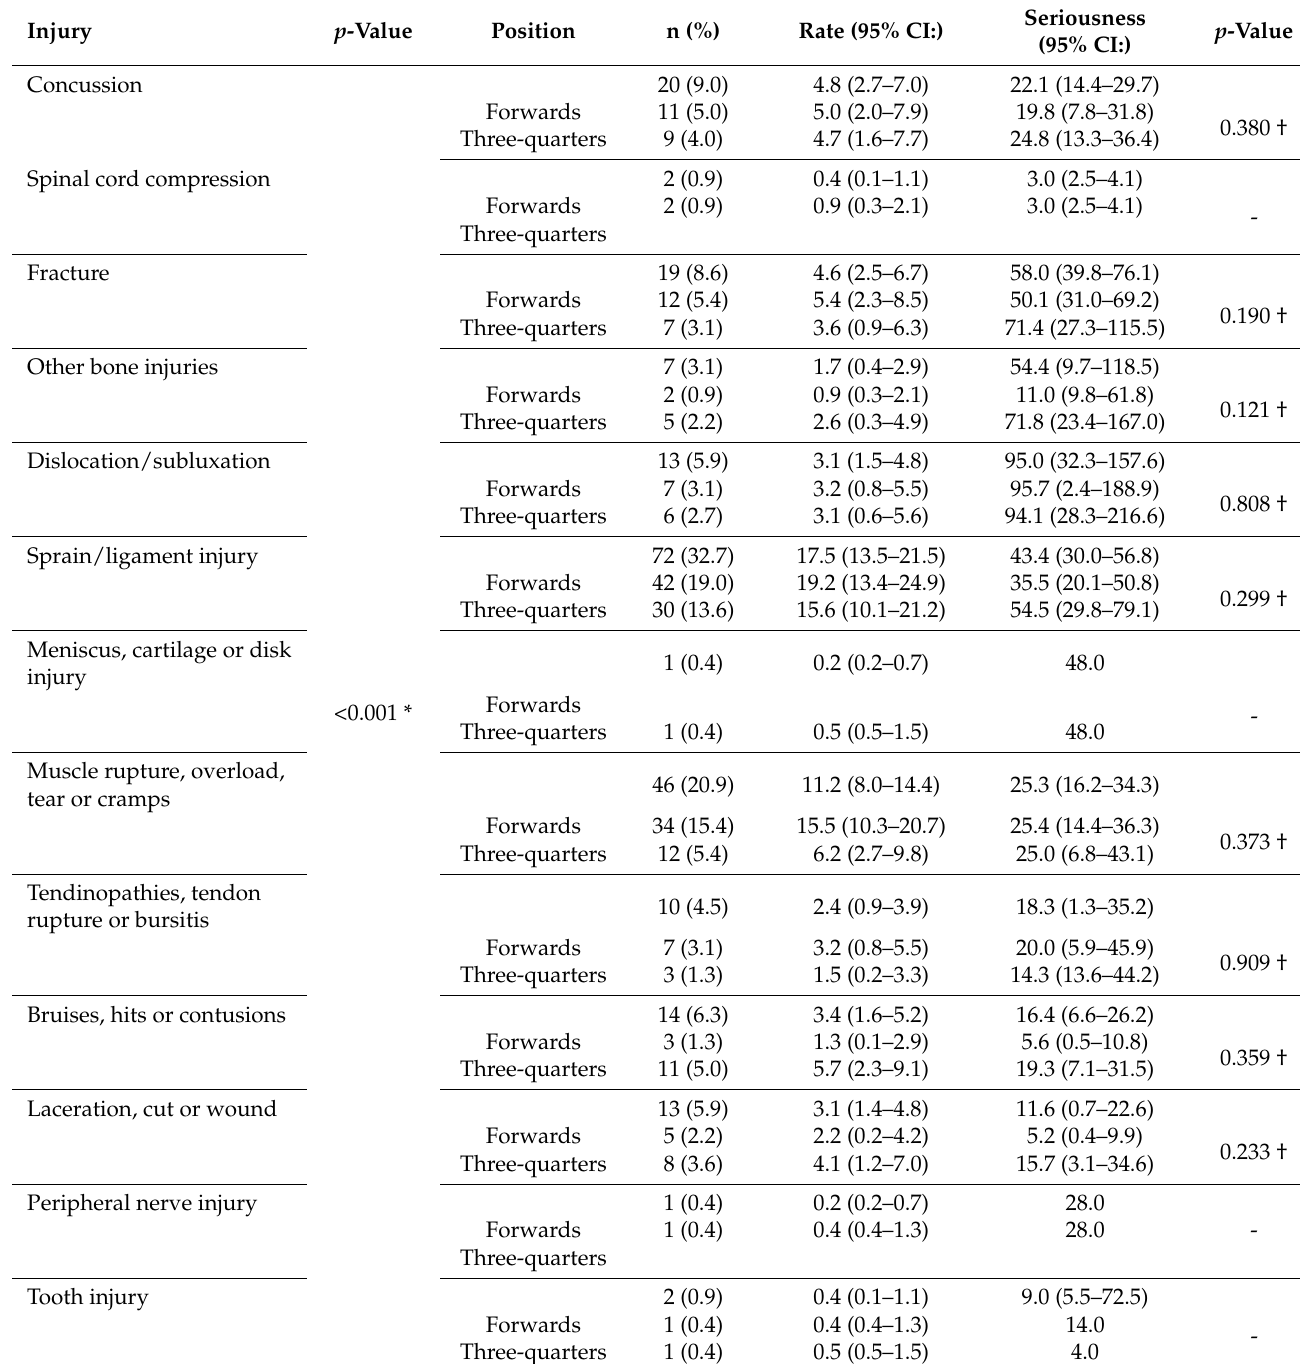
Table 5. Rate and seriousness of all injuries distributed by type of